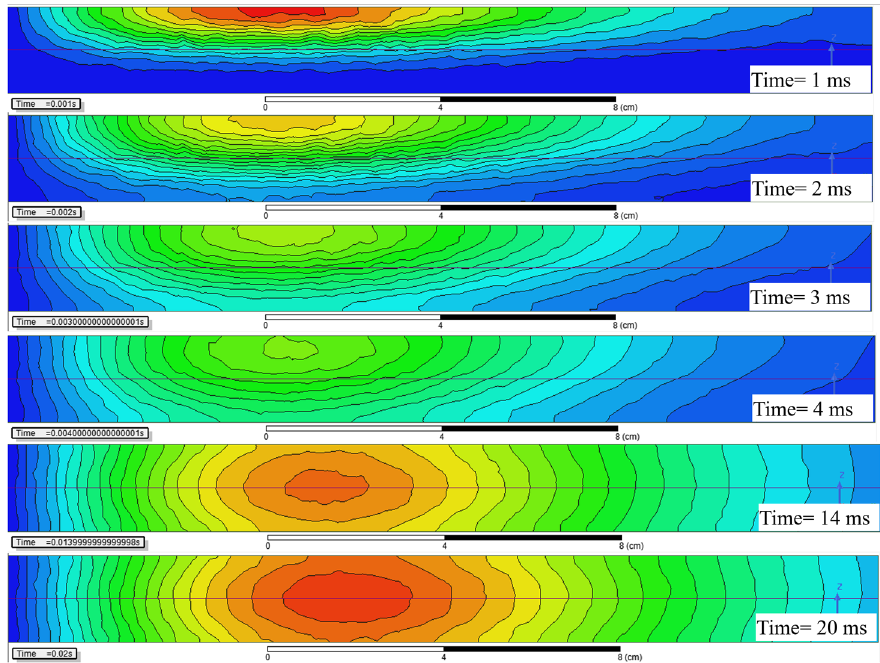
Figure 5. The distribution of eddy current density (ECD) in a 20 mm thick aluminum plate with the same color scales shown in Figure 3b, in which the maximum values of ECD are set to 70 kA/m (cid:2870) , 55 kA/m (cid:2870) , 50 kA/m (cid:2870) , 45 kA/m (cid:2870) , 15 kA/m (cid:2870) and 10 kA/m (cid:2870) , respectively.